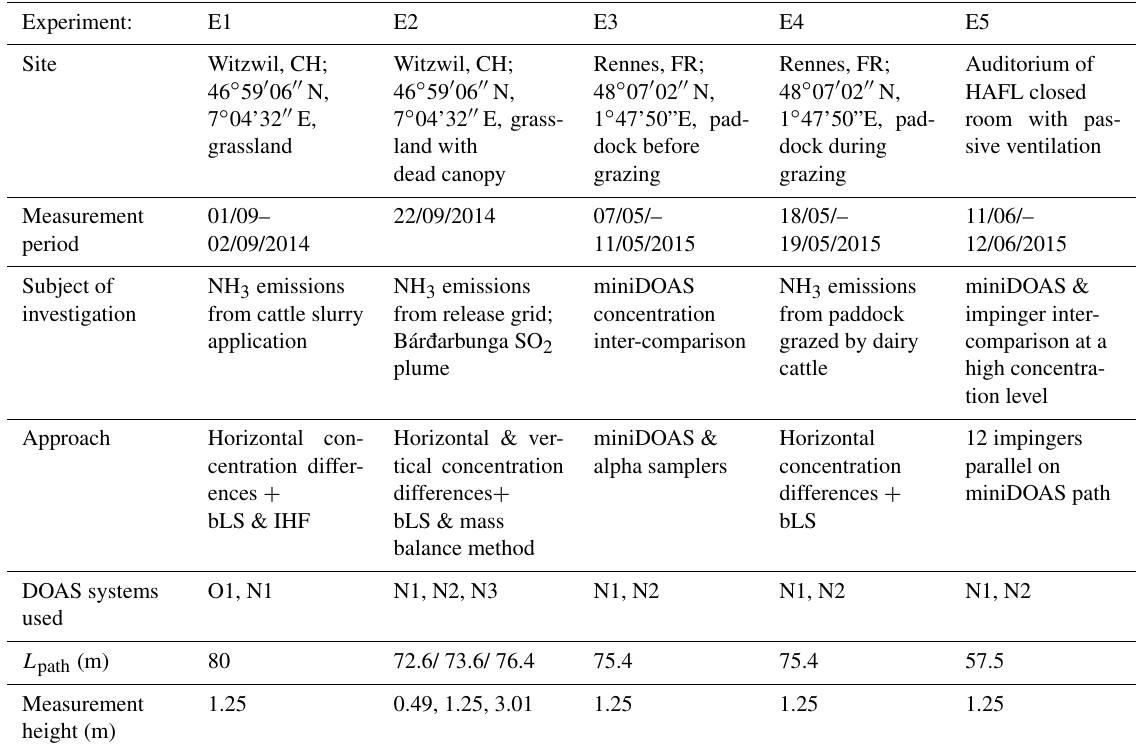
Table 1. Overview of experimental trials as examples for miniDOAS applications.